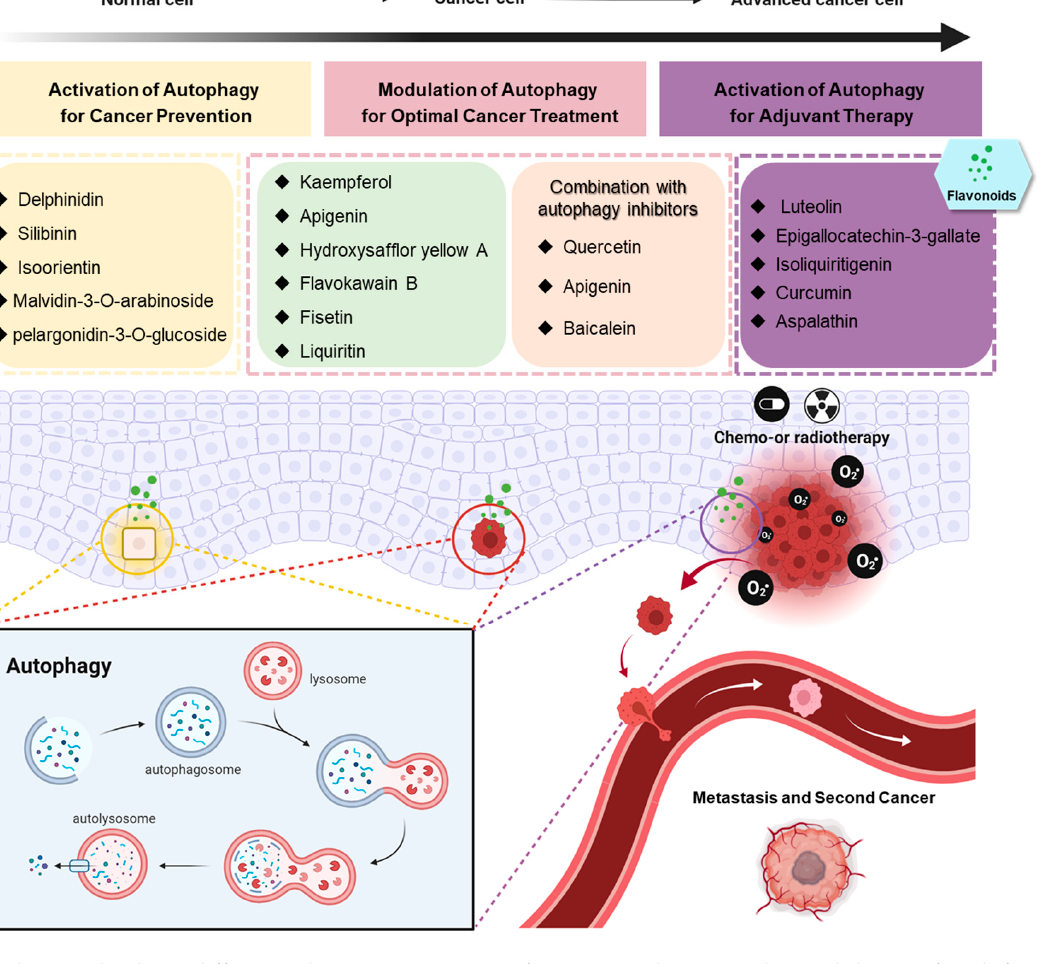
Figure 2. Flavonoids play a different role in various stages of cancer, attributing to the modulation of multifunctional autophagy. This figure was created using BioRender.